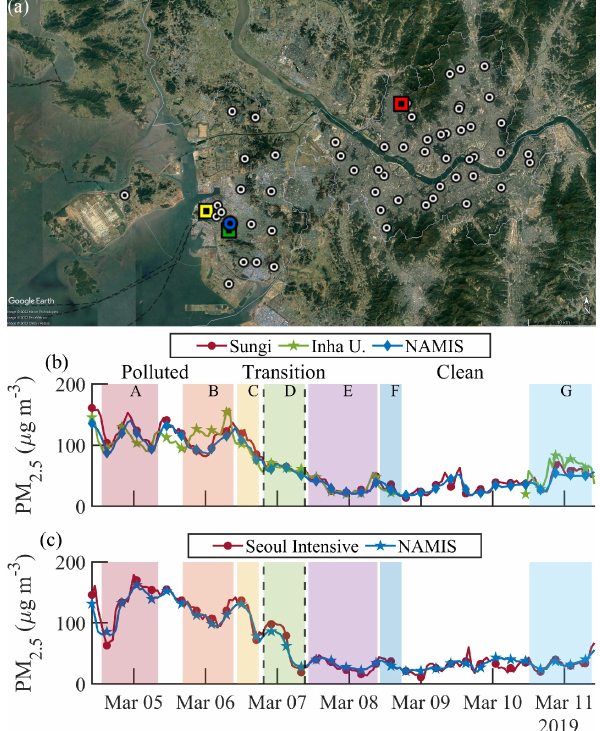
Figure 1. (a) Spatial map showing the 17 and 40 National Ambi- ent air quality Monitoring Information System (NAMIS) stations in Incheon and Seoul, respectively, along with the three main surface sites relied on for this study (yellow: Incheon meteorological site, green: Inha University, blue: Sungi – also a NAMIS station, red: Seoul Intensive Monitoring Station). PM 2 . 5 comparison between (b) city-wide Incheon mean values and those for Sungi and Inha University and between (c) city-wide Seoul mean values and those for Seoul Intensive Monitoring Station. Coefficients of determina- tion ( R 2 ) between the data points: (b) (Inha University) R 2 = 0 . 82 and (Sungi) R 2 = 0 . 98; (c) R 2 = 0 . 96. Shaded regions of (b–c) are labeled with individual DLPI + sets overlapping in time. All times are reported in Korea standard time (KST); KST is UTC +